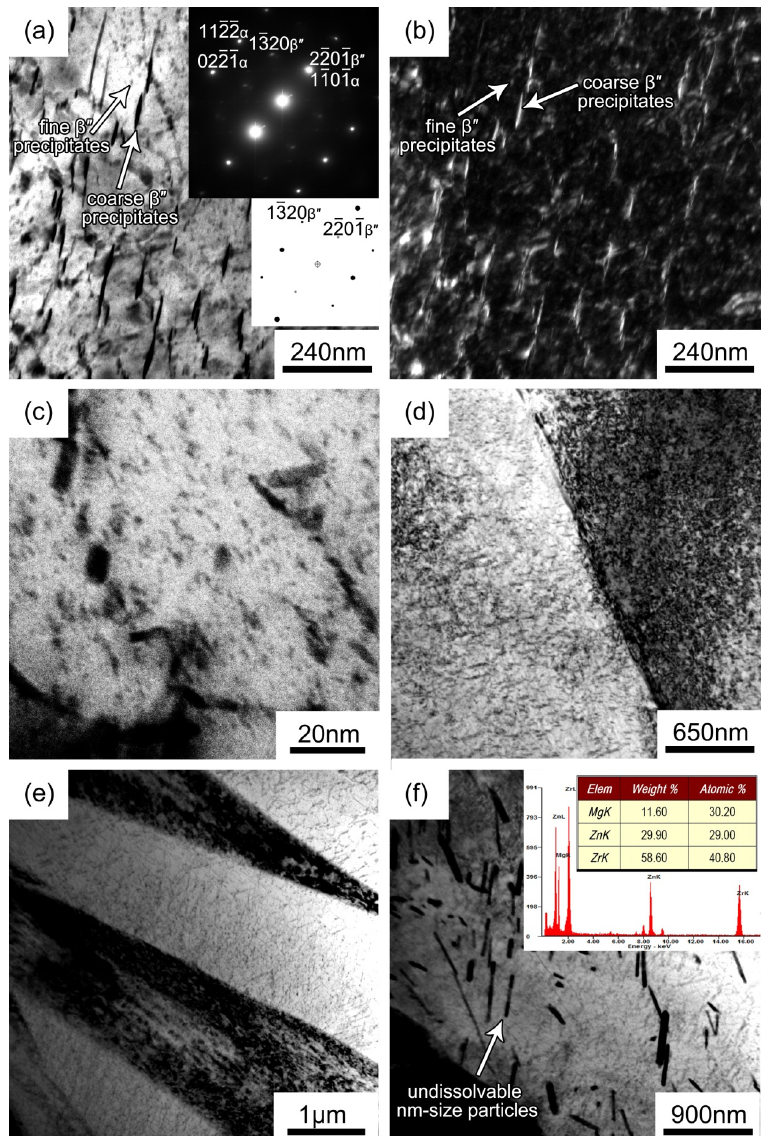
Figure 6. TEM images of specimen subjected to 8% pre ‐ stretching and subsequently aged at 200 °C for 8 h: ( a ) and ( b ) are bright ‐ field and dark ‐ field morphology of plate ‐ shaped precipitates in the matrix (B//[5146] α ), respectively; ( c ) is high magnification TEM image of the fine precipitates; ( d ) and ( e ) are bright ‐ field morphology of grain boundaries and twins, respectively; and ( f ) is bright ‐ field morphology of undissolvable particles and corresponding EDXS recorded from an undissolvable particle.